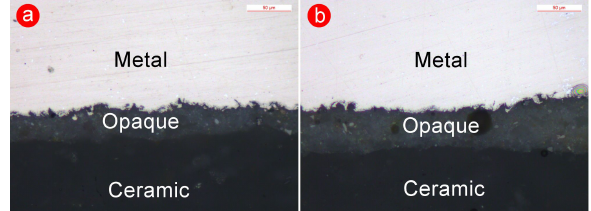
Figure 10: Metallographic images of the sample interfaces at 200x magnification: (a) drop form alloy, (b) plate form alloy